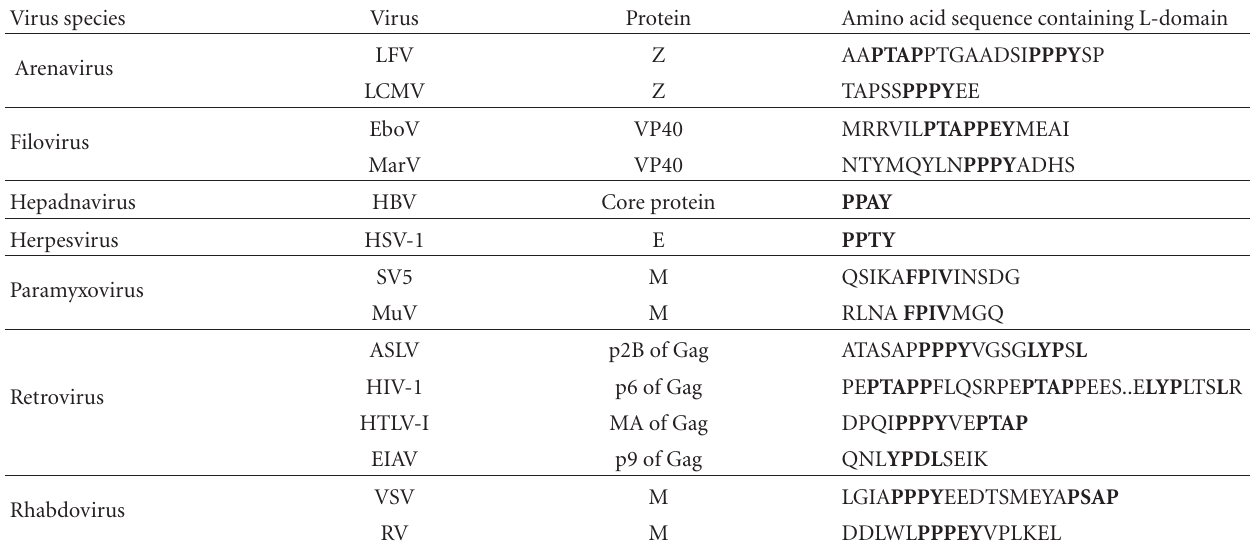
Table 1: L-domains found in enveloped virus proteins, which bud from the cell membrane in an ESCRT-dependent process: Lassa fever virus (LFV) [39], lymphocytic choriomeningitis virus (LCMV) [39, 40], Ebola virus (EboV) [2], Marberg virus (MarV) [41], hepititus B virus (HBV) [42], Herpes simplex virus, type 1 (HSV-1) [43], Simian virus, type 5 (SV5) [44], Mumps virus (MuV) [45], avian sarcoma leukemia virus (ASLV) [11, 14, 15], human immunodeficiency virus, type 1 (HIV-1) [2, 10, 27], human T-lymphotropic virus, type 1 (HTLV-1) [2],